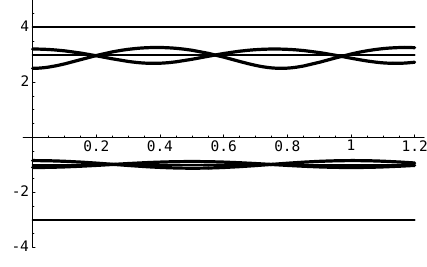
Figure 7. Solutions in neighborhoods of the p 2 and p 4